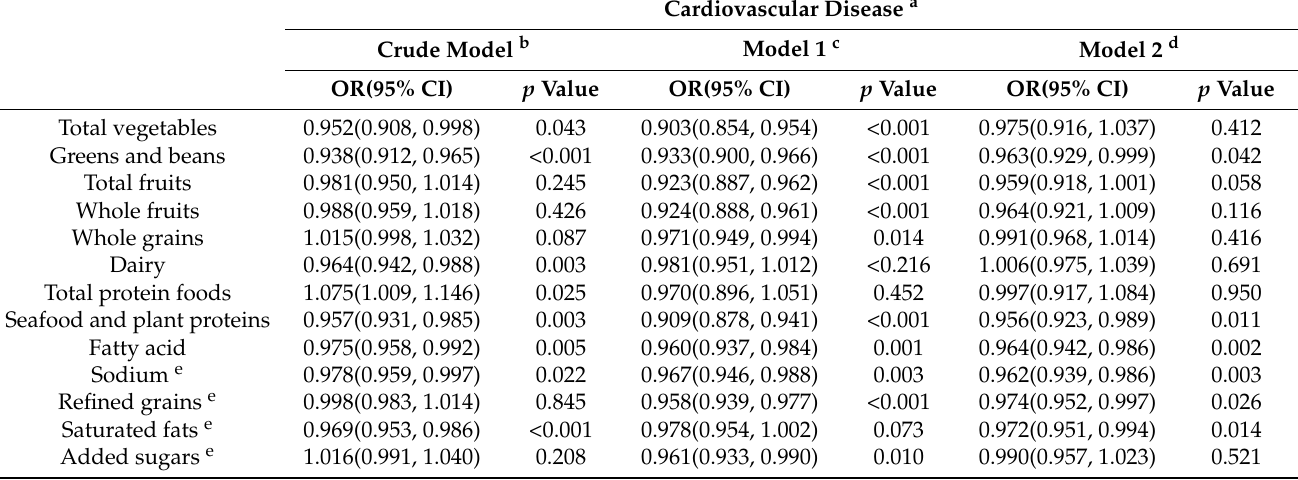
Table 4. Weighted odds ratios (ORs) with 95 percent confidence intervals (CIs) for diet components and the risk of